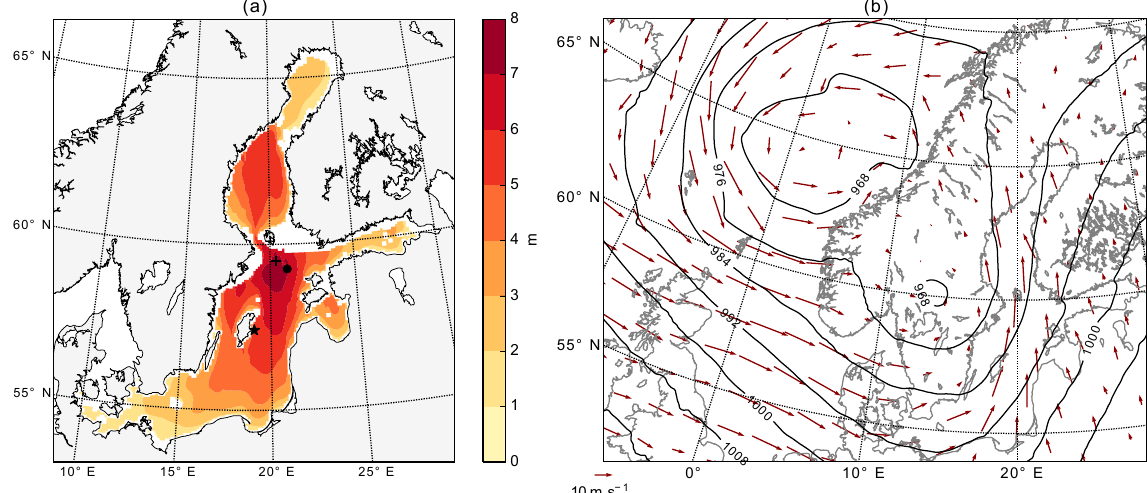
Figure 1. The modelled significant wave height at 22:00UTC (a) and the meteorological conditions at 21:00UTC (b) during storm Toini in 11 January 2017. The locations of the NBP wave buoy (circle), the Gotland wave buoy (star) and Bogskär wind measurements (plus) are also shown in (a)